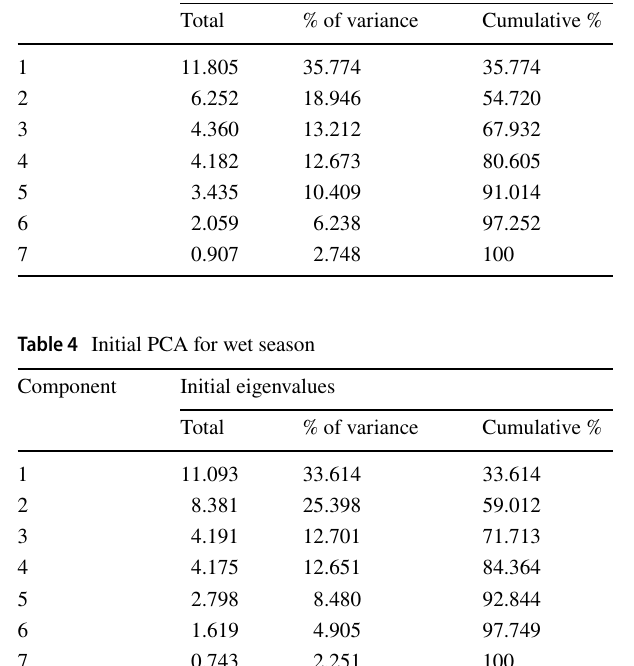
Fig. 8 Water quality index for the Densu river Table 3 Initial PCA for dry season Component